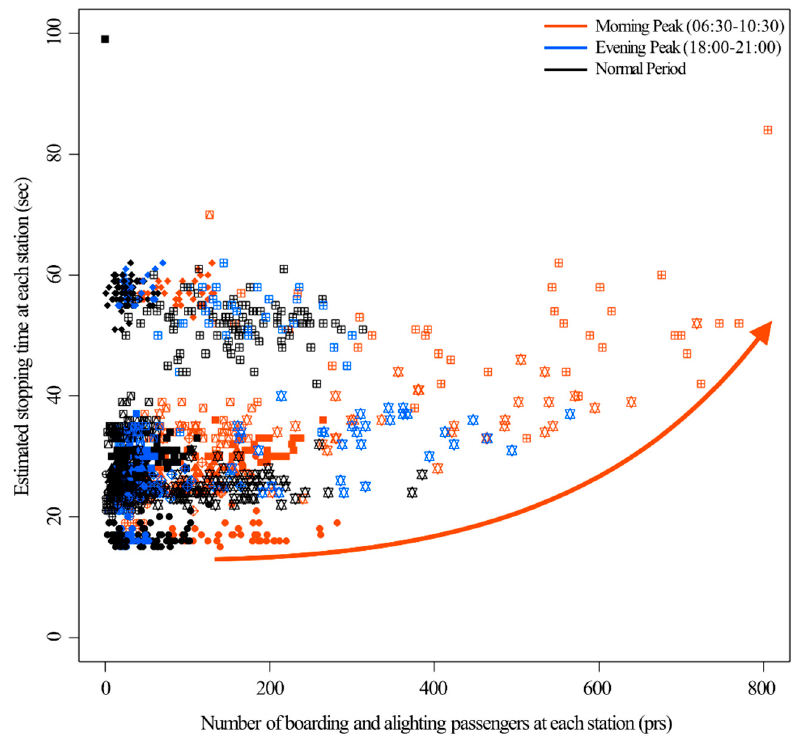
Figure 7. Relationship between estimated dwell time and the number of boarding and alighting passengers at each station of S line.